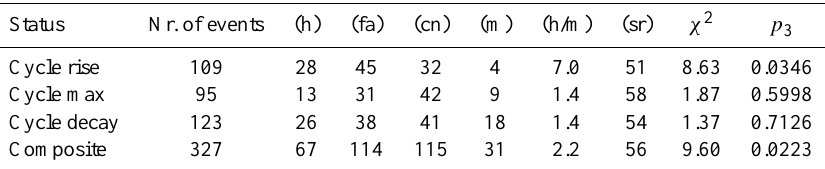
Table 8. Performance of the HAFv.2 model with respect to shocks with speeds < 1200kms − 1 at helio-longitudes > 20 ◦ during each of the key phases of solar cycle 23 and during the total cycle. Status Nr. of events